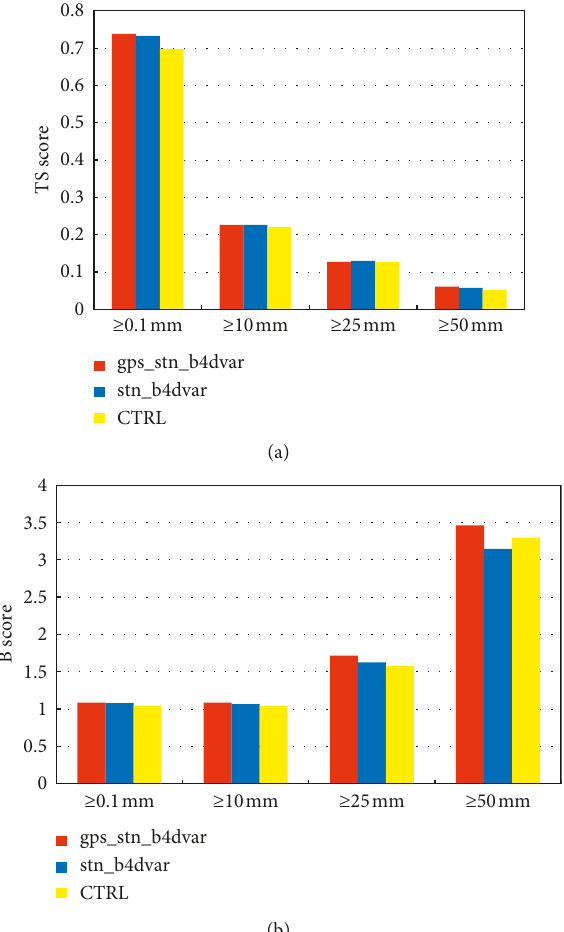
Figure 7: Comparison of the 48-hour cumulative precipitation (a) TS scores and (b) B scores for several schemes from May 4, 2009, to August 30,